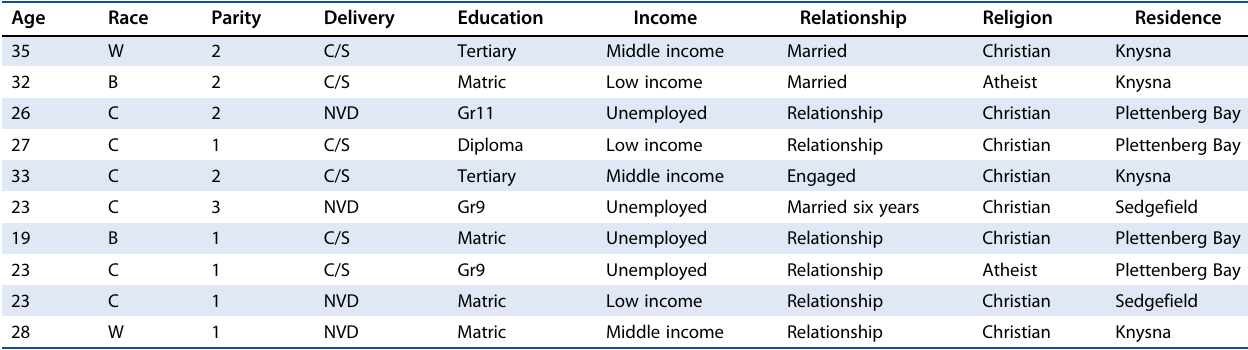
Table 1: Demographics of participants Age Race